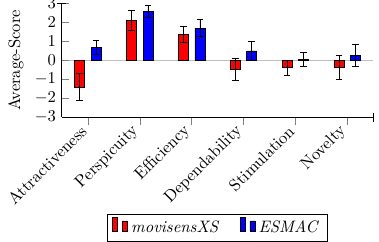
Figure 4: UEQ results for both web interfaces.